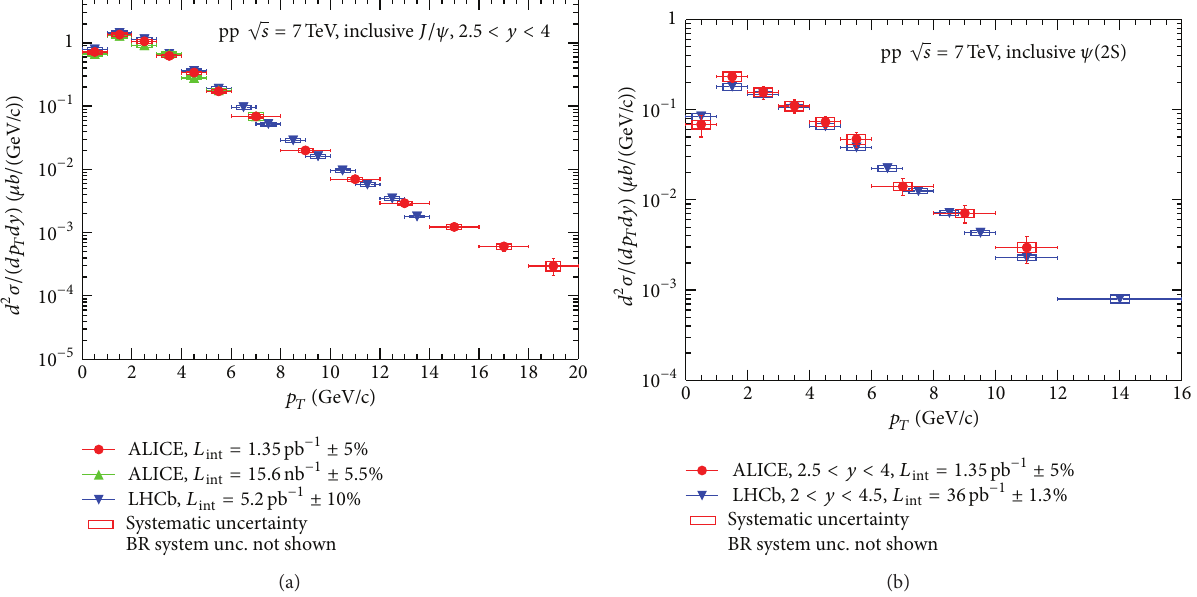
Figure 2: Comparison of charmonium production cross sections in p-p collisions at 7 TeV versus transverse momentum for ALICE and LHCb data for 𝐽/𝜓 (a) and 𝜓 (2S)